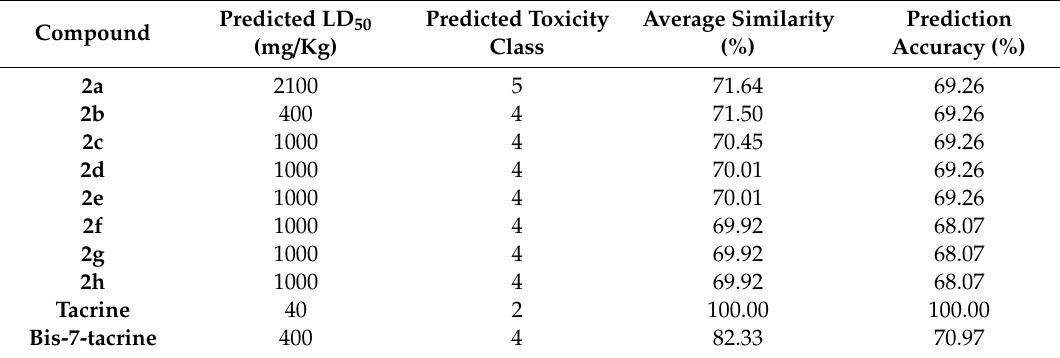
Table 3. LD 50 and toxicity class prediction of tacrine, bis-7-tacrine, and 2a - 2h hybrids. The prediction was performed with ProTox-II (http: // tox.charite.de / protox_II), a web-server for the prediction of small molecule toxicity